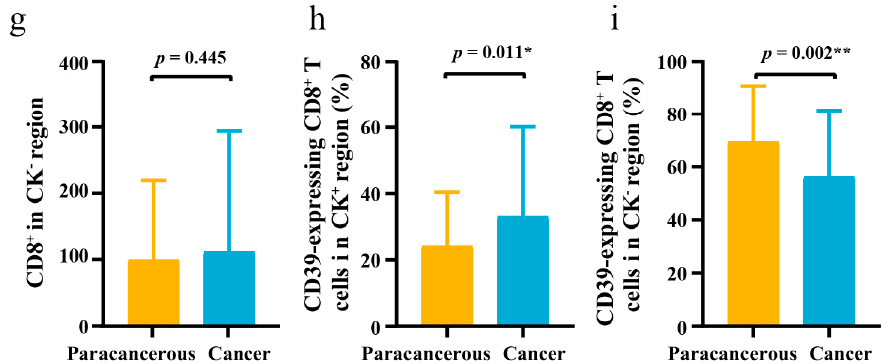
Figure 1. The difference of CD39 expression in 71 pairs of ESCC cancer tissues and paracancerous tissues. ( a – c ) The differences of CD39 + count, CD8 + count, and CD39-expressing CD8 + T cells between ESCC cancer tissues and paracancerous tissues; ( d – f ) The differences of CD39 + in CK + region, CD39 + in CK − region, and CD8 + in CK + region between ESCC cancer tissues and paracancerous tissues; ( g – i ) The differences of CD8 + in CK − region, CD39-expressing CD8 + T cells in CK + region, and CD39-expressing CD8 + T cells in CK − region between ESCC cancer tissues and paracancerous tissues. CD39, ectonucleoside triphosphate diphosphohydrolase 1; CK, cytokeratin; ESCC, esophageal squamous cell carcinoma; IQR, interquartile range; SD, standard deviation. The error bar represents median and interquartile range (IQR) in ( a , b , d – g ). The error bar represents mean and standard deviation (SD) in ( c , h , i ). * p < 0.05, ** p < 0.01, *** p < 0.001.